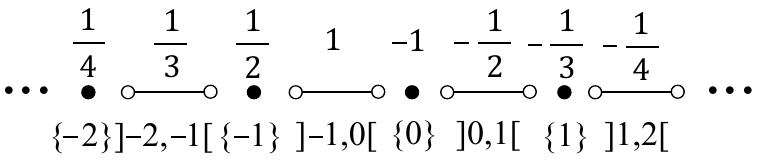
Figure 1. Bijection between G 1 and Z